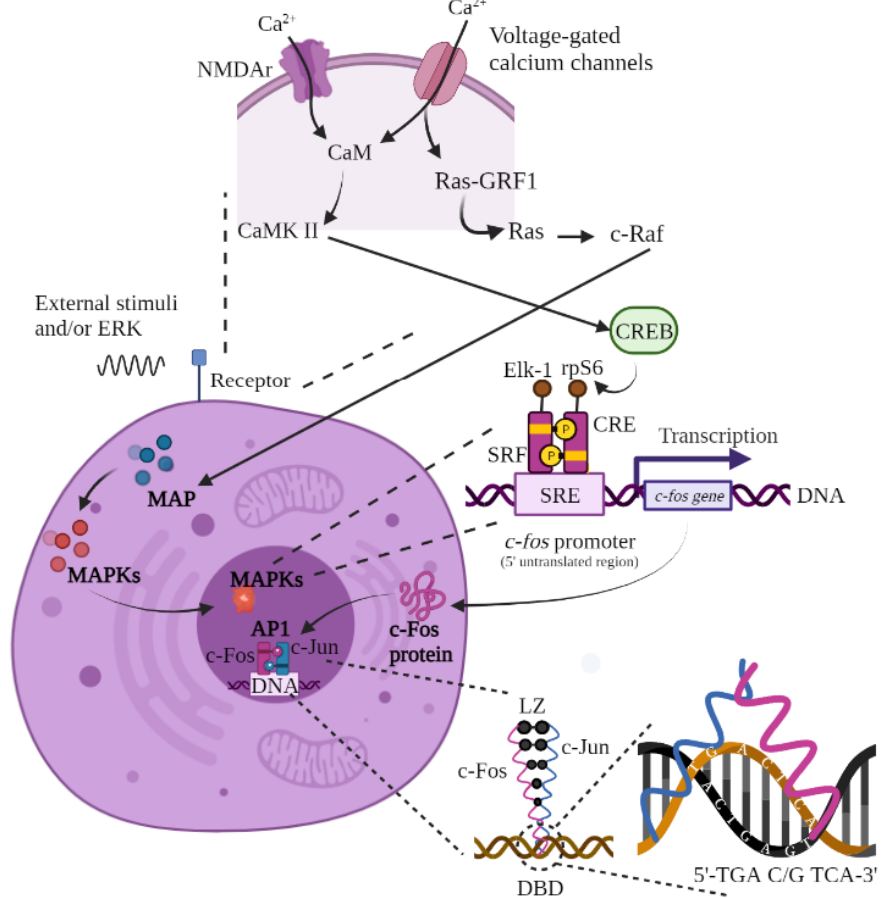
Figure 1. Synthesis of c-Fos. Calcium fluxes into the neuron during action potentials via NMDAr and voltage-dependent calcium channels. The influx of calcium binds calmodulin, activating CaMK II or IV and then CREB. NMDAr activity also activates RasGRF1, activating the MAPK (I, II, or III) pathway via Ras and c-Raf activation. The synthesis process for the Fos protein begins with an extracellular stimulus that activates the MAPK cascade and the c-fos gene through binding of the Elk-1, CRE, SRF, and rpS6 proteins to the SRE promoter. The active c-fos gene leads to translation of the c-Fos protein at the nucleus level and its subsequent transcription in the cytoplasm. Once created, c-Fos returns to the cell nucleus to bind to c-Jun and form the AP-1 heterodimer, which will be integrated into the DNA of the target gene (in the 5 (cid:48) TGA C/G TCA-3 (cid:48) sequence) to trigger the desired answer. The basic leucine zipper allows for the union of c-Fos and c-Jun. Figure of